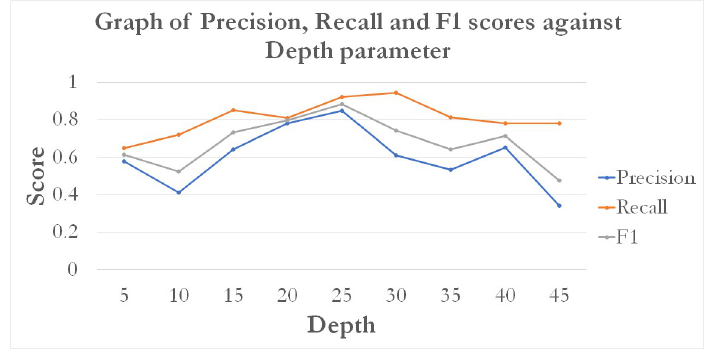
Fig 13. A graph of model performance scores (precision, recall and F1) based on varying MLP depths.